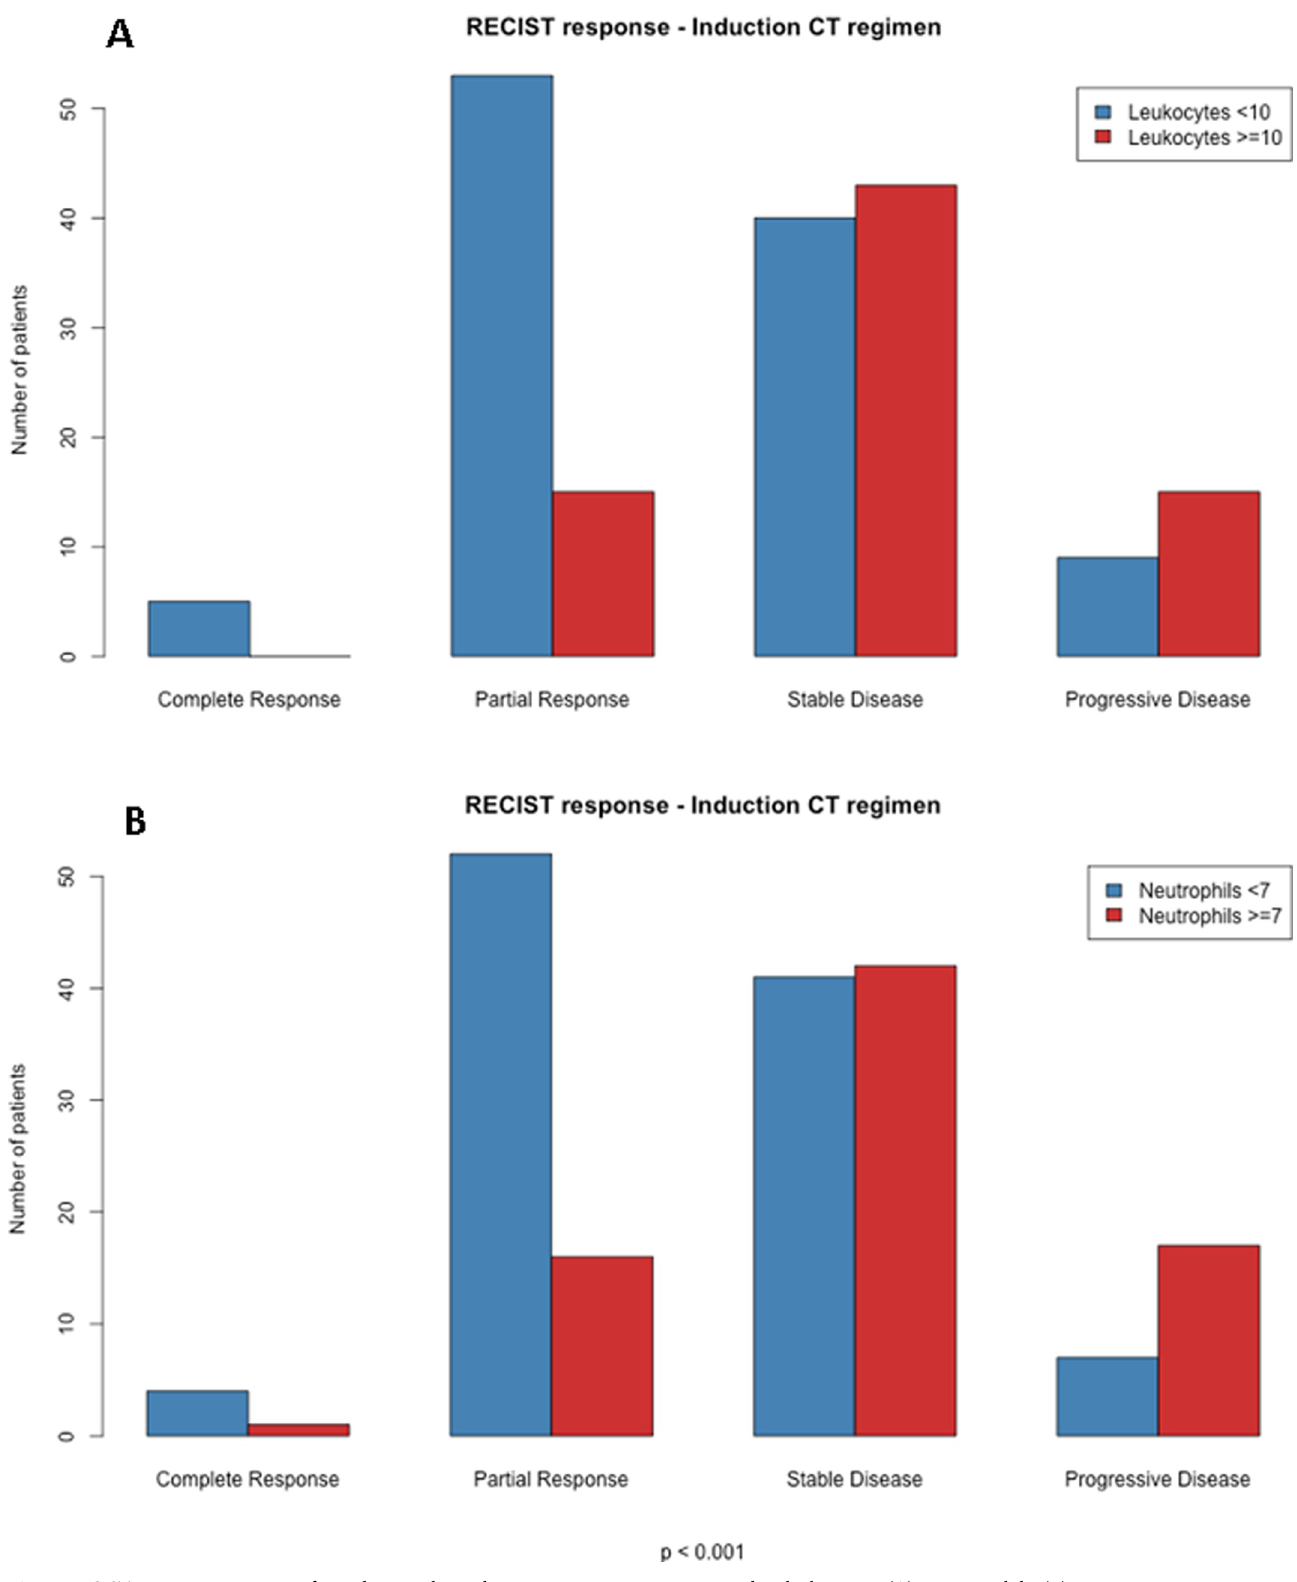
Fig 1. RECIST response assessment after induction chemotherapy in stage-III patients, regarding leukocytosis (A) or neutrophilia (B).